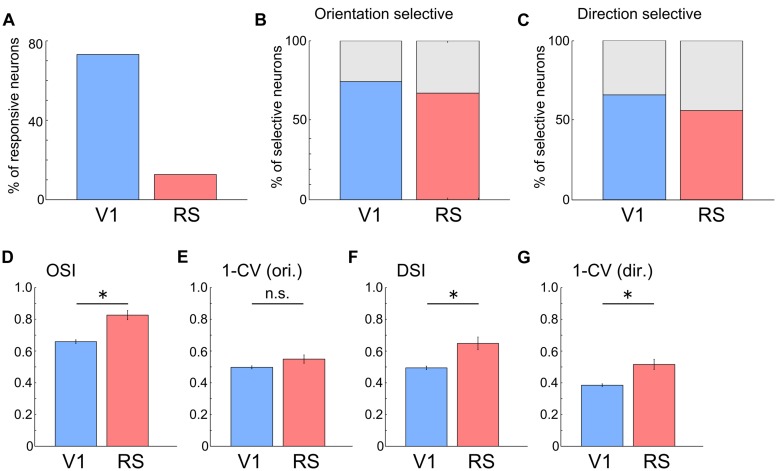
Orientation and direction selectivity in the RS. (A) Proportion of responsive neurons to all recorded neurons. V1: 73.1%, 518/708 neurons; RS: 12.7%, 82/645 neurons. (B) Proportion of orientation selective neurons to all responsive neurons. V1: 74.3%. RS: 67.1%. (C) Proportion of direction selective neurons to all responsive neurons. V1: 65.8%. RS: 56.1%. (D–G) Comparison of OSI (D, V1: 0.66 ± 0.01, RS: 0.83 ± 0.03), 1-CV (orientation) (E, V1: 0.50 ± 0.01, RS: 0.55 ± 0.03), DSI (F, V1: 0.49 ± 0.01, RS: 0.65 ± 0.04) and 1-CV (direction) (G, V1: 0.38 ± 0.01, RS: 0.52 ± 0.03) between neurons in V1 and RS. ∗p < 0.05, n.s.: non-significant by Wilcoxon’s rank-sum test.